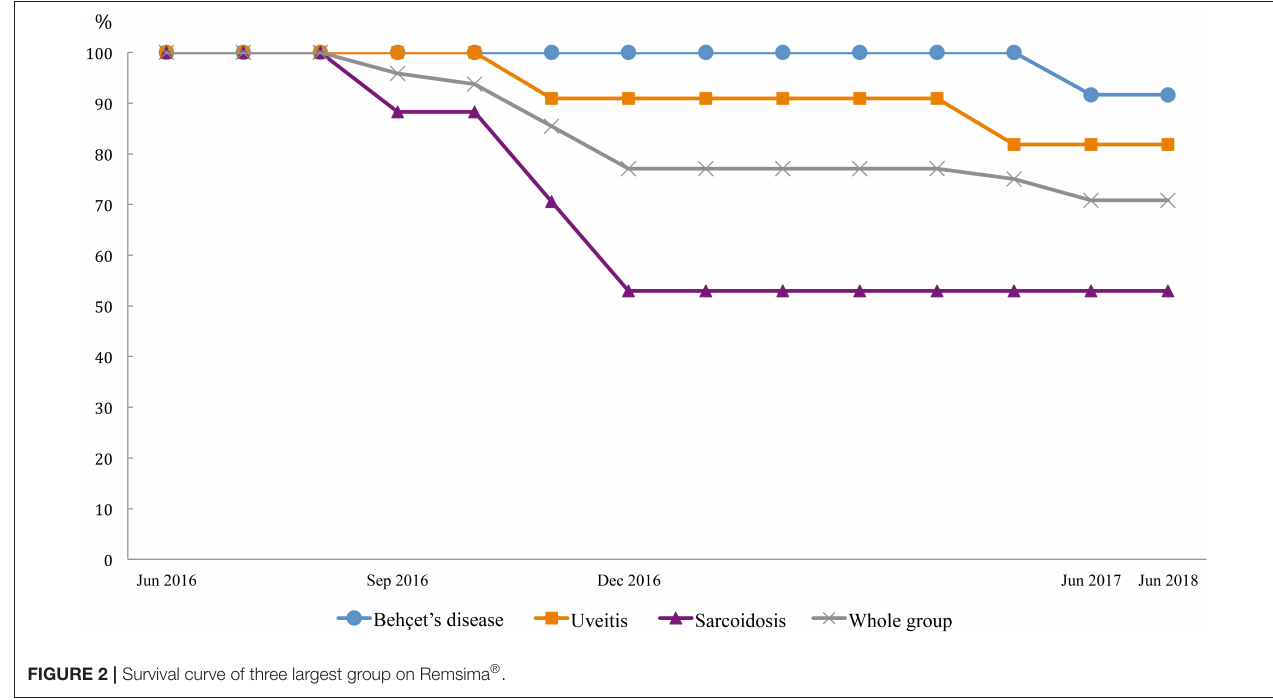
FIGURE 2 | Survival curve of three largest group on Remsima ® .